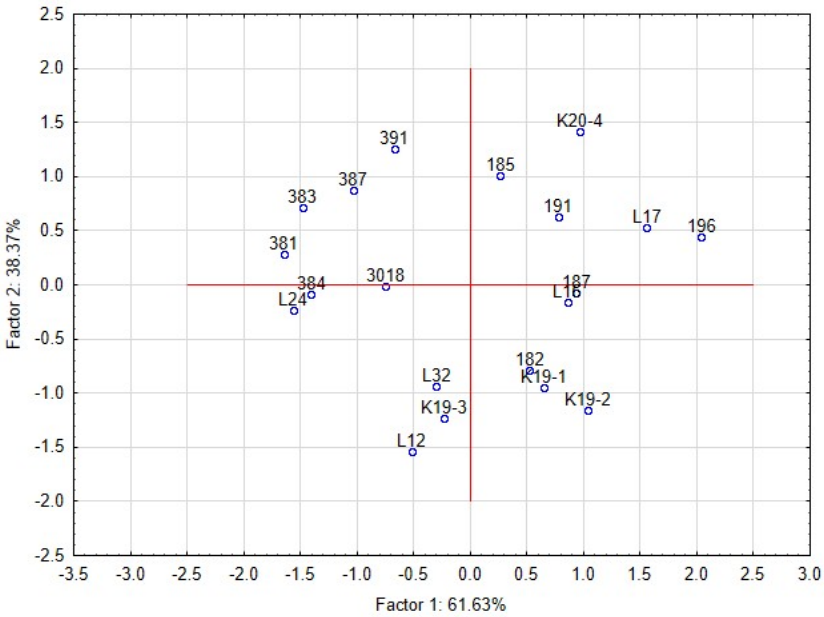
Figure 8. Principal component analysis (PCA) on the standardised values of the average size of yeast colonies (mm) representing the interaction among lactobacilli and yeast contaminants in RSM matrix. Scatter plot of the position of strains of L. plantarum is based on correlations among its functional properties.